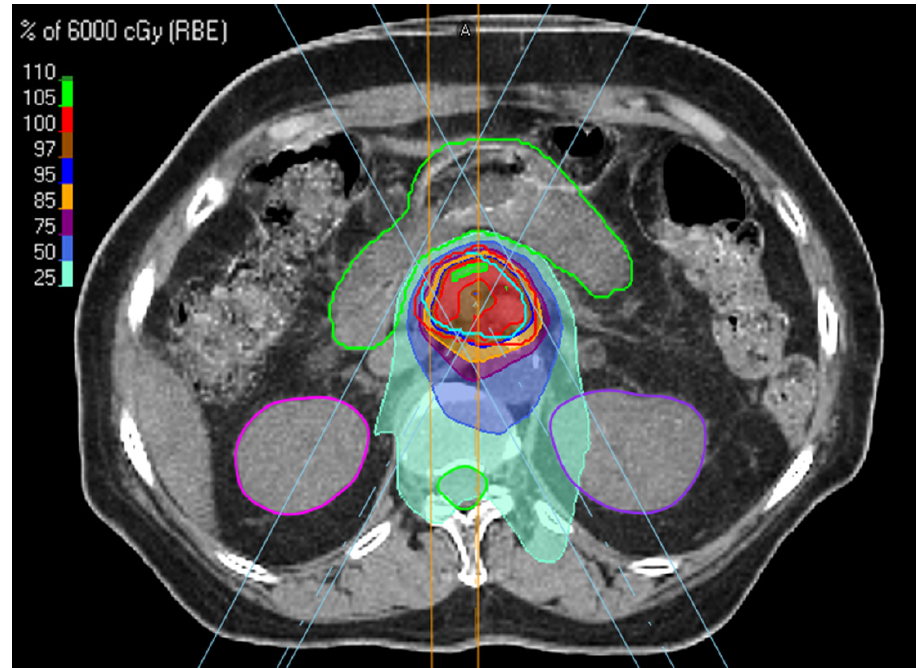
Figure 1. Beam arrangement and dose distribution in SBPT planning .